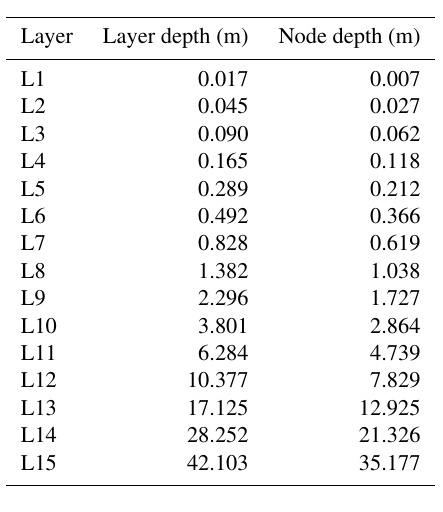
Table 1. Soil layers and node depths in the CLM4. Note that the node depths, which are the depths at which the thermal properties are defined for soil layers (Oleson et al., 2010), do not necessarily coincide with the center of the layer